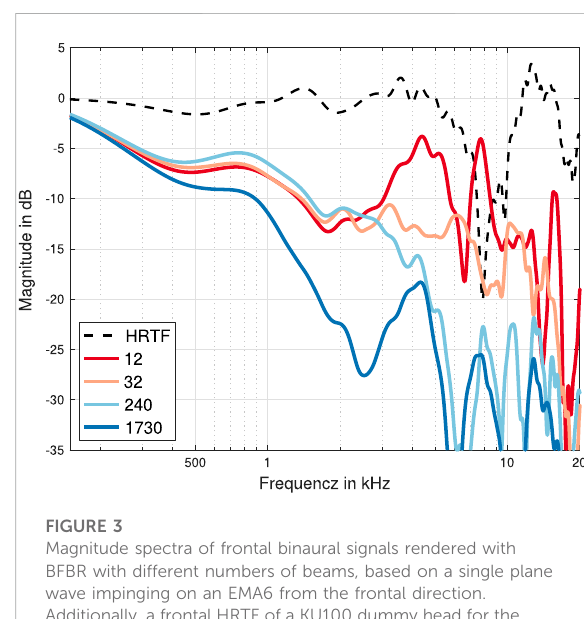
1730 surrounding source positions on a N = 35 Lebedev grid.